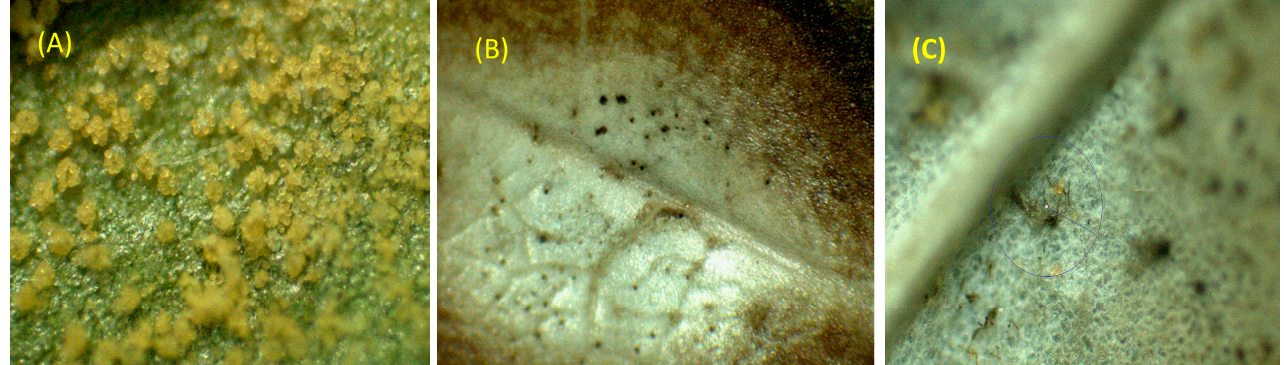
Figure 3. Detail of the evolution of the control of uredospores deposited on the leaves after application or treatment with oil. Image of the control without biopesticides ( A ), 15% oil after 24 h apparently the uredospores have burned ( B ) and after one week there is evidence of regeneration and disappearance of the rusts in the plant tissue ( C ).